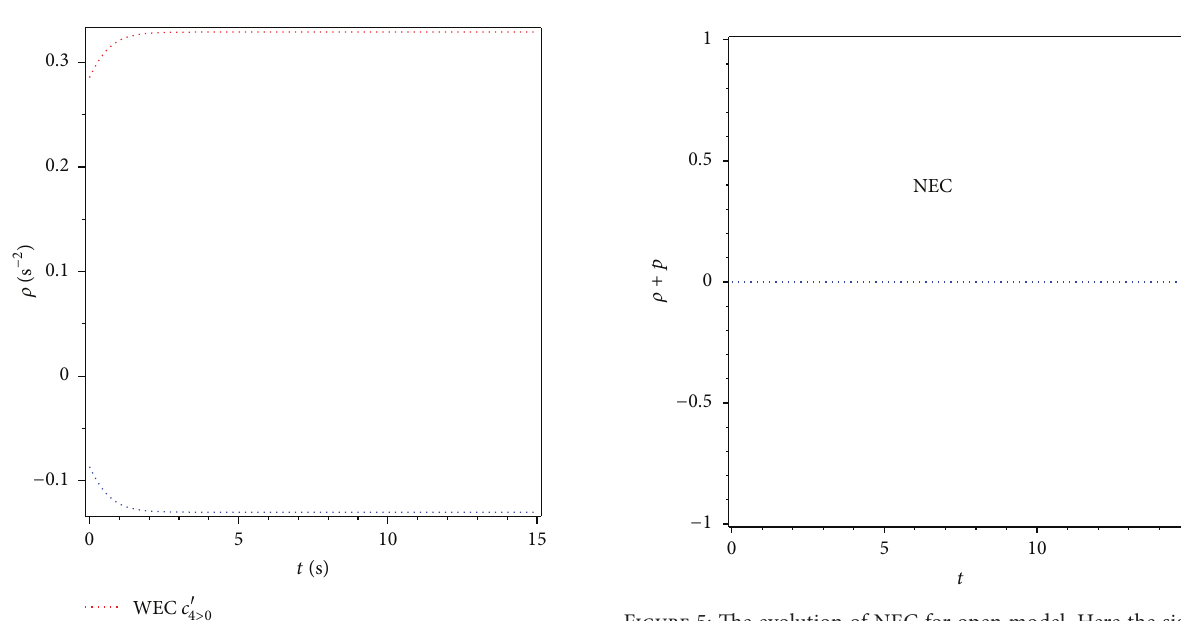
Figure 5: The evolution of NEC for open model. Here the sign of the four constants 𝑐 󸀠 1 , 𝑐 󸀠 2 , 𝑐 󸀠 3 , and 𝑐 󸀠 4 has no effect on the evolution of NEC.